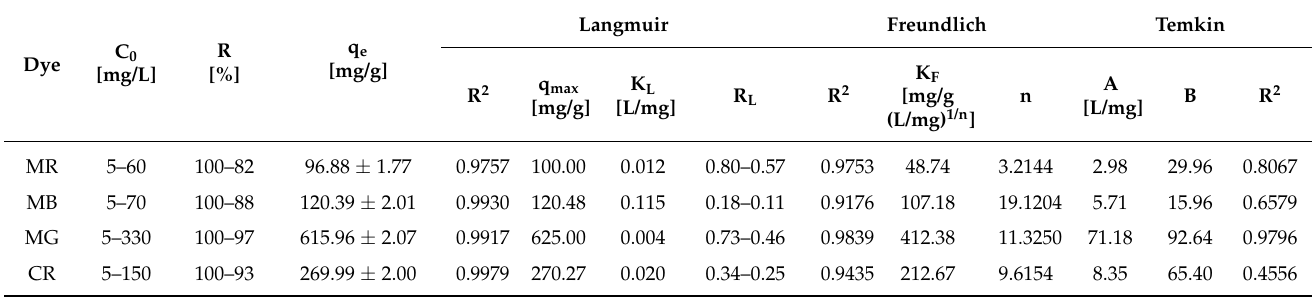
Table 5. Langmuir, Freundlich and Temkin parameters of the adsorption isotherms of organic dyes onto activated